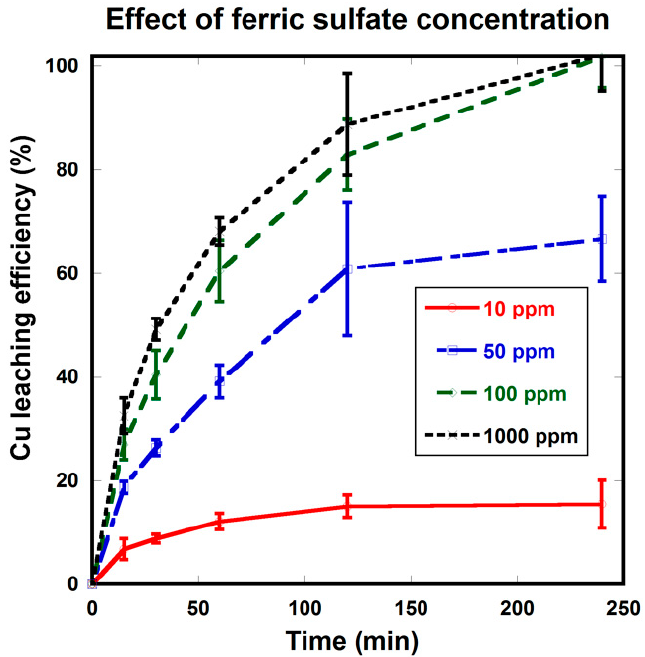
Figure 3. Effect of ferric sulfate concentration (Temperature—20 °C, agitation—150 rpm, and pulp density—10 g·L − 1 ).